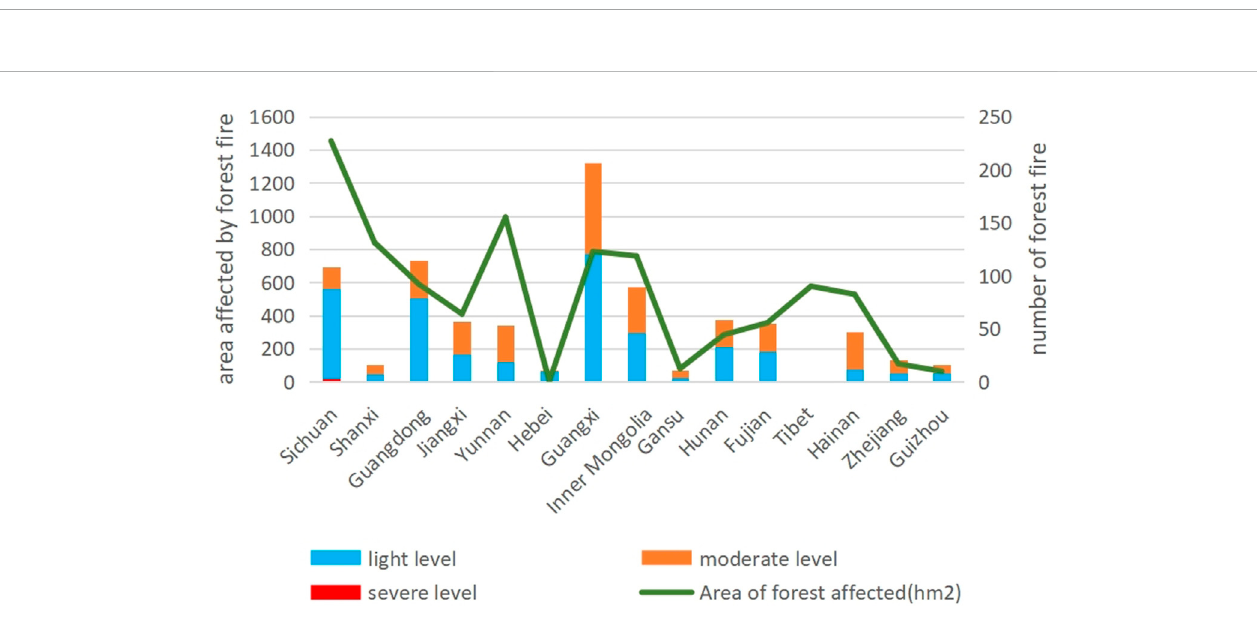
FIGURE 2 theareaaffectedbyforest fi resandthenumberofforest fi resinthesampleprovincesin2020.Note:InFigure2,themainaxisshowstheareaaffectedwhilethe secondary axis shows the number of different levels of fi res affected. According to both fi re characteristics in sample provinces we classify them into three